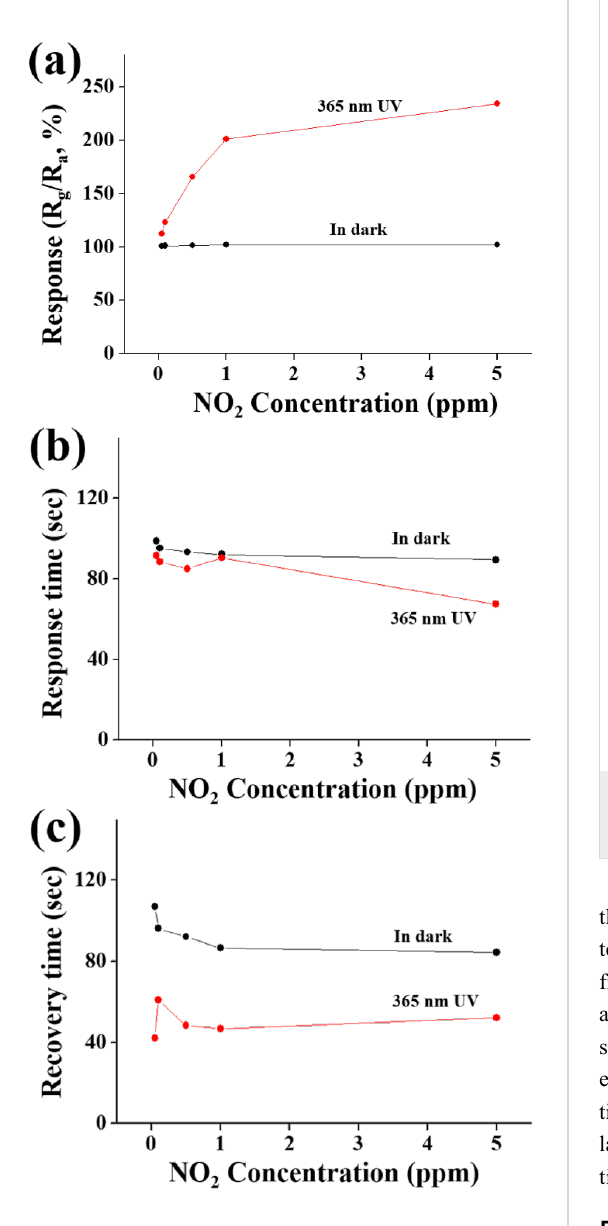
Figure 4: (a) Response, (b) response times and (c) recovery times of the multiple-networked ZnSe nanowire gas sensor to NO 2 gas in the dark and under 365 nm UV illumination at 1.2 mW/cm 2 .